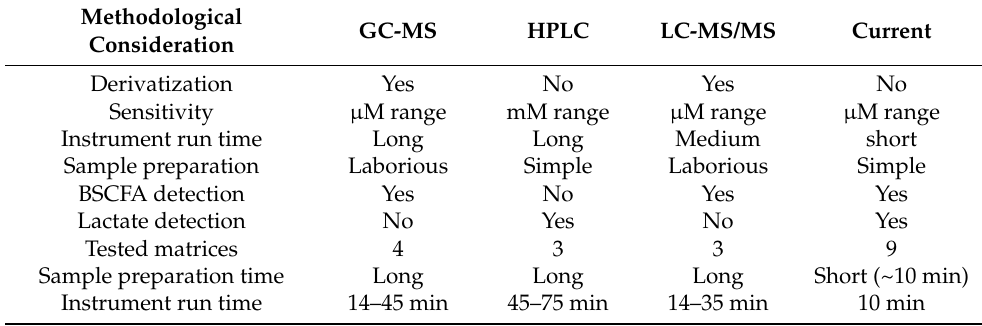
Table 5. A comparison of previous techniques with the new technique reported